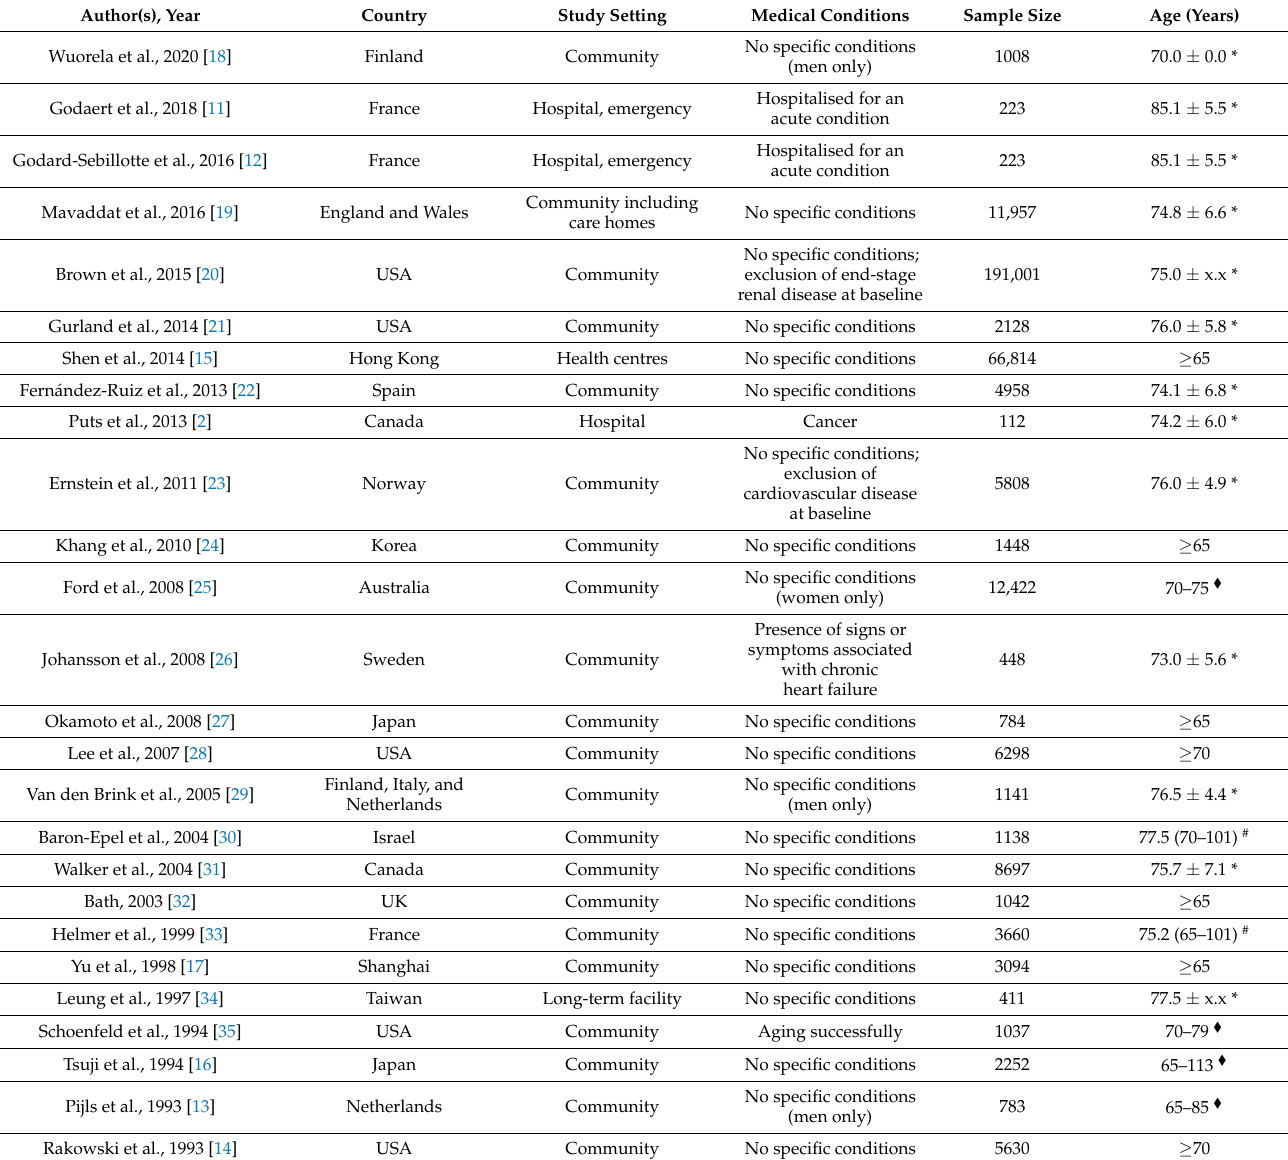
Table 1. Description of the studies included in the present systematic